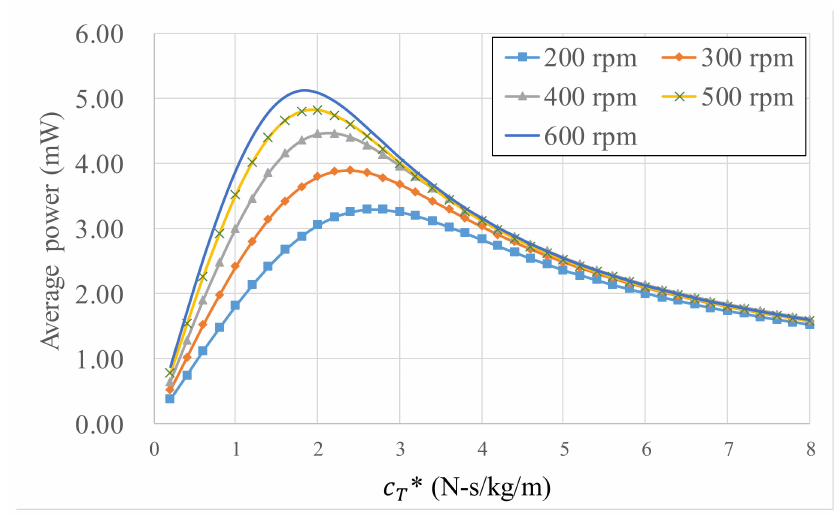
Figure 2. Electrical power varies with C T * at different wheel rotation speeds.